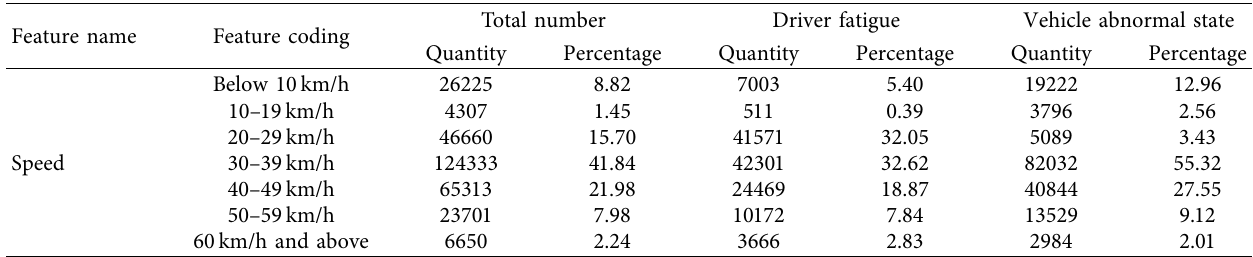
Figure 7: Comparative analysis of partial forewarning areas: (a) driver fatigue forewarning; (b) vehicle abnormal state forewarning. Table 5: Distribution of bus forewarning types under different speed